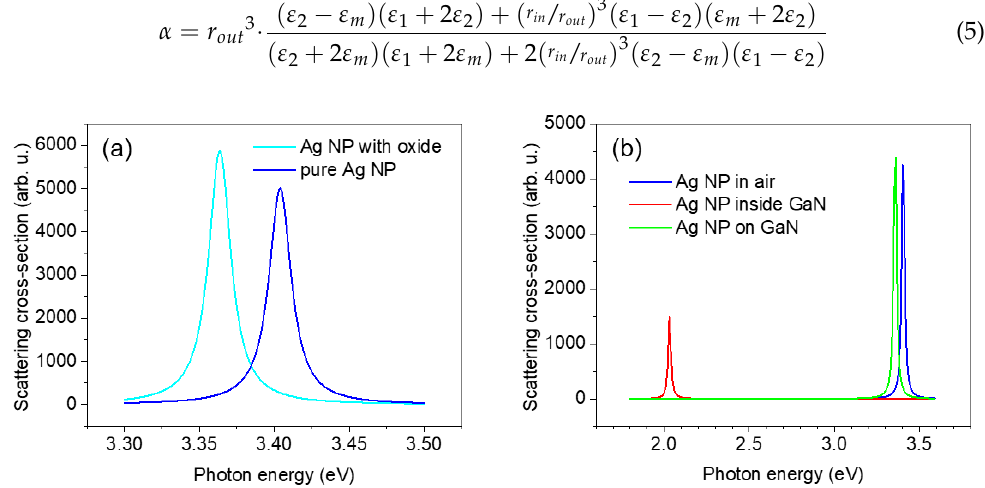
Figure 5. ( a ) The scattering cross-section spectra calculated for a bare silver nanoparticle in air (blue line) and for the Ag NP covered with a 1.5 nm thin oxide film (cyan line). ( b ) The scattering cross-section spectra are compared for the Ag NP in air (blue line), embedded in GaN (red line), and placed on the GaN surface with contact area of 10 % (green line).